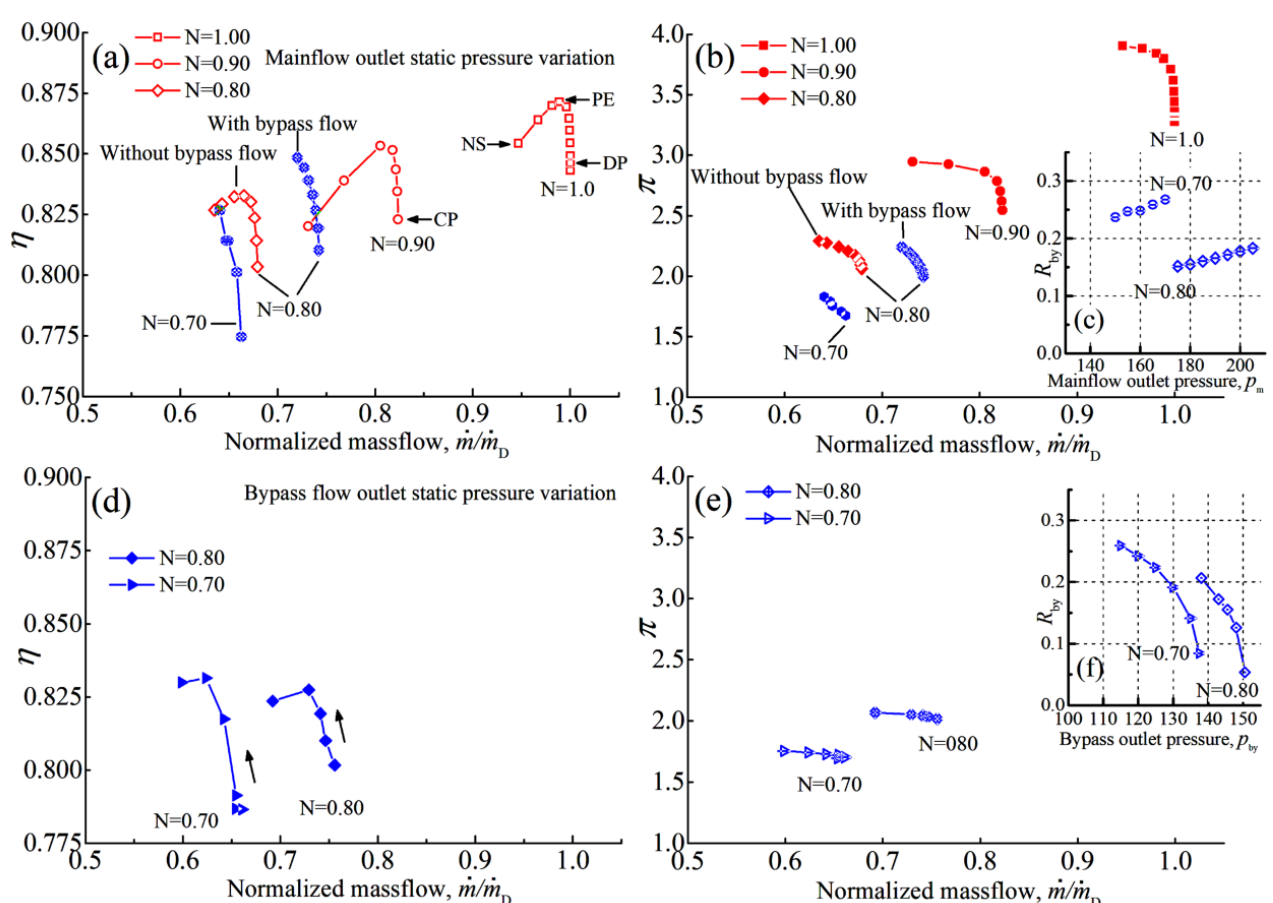
Figure 3. The aerodynamic performance of main flow ( a – c ) and bypass flow ( d – f ) of baseline transonic two-stage transonic compressor at different relative rotating speeds ( N C = 1.0 to